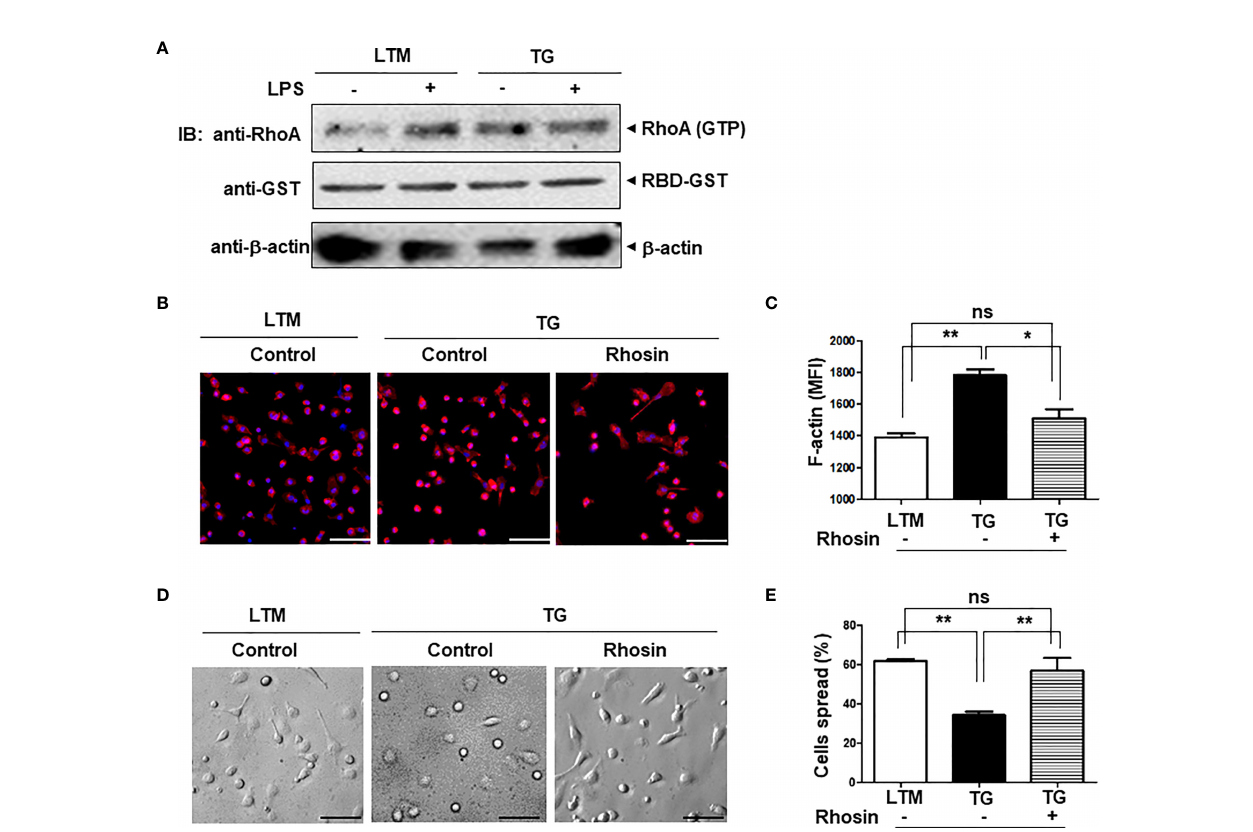
FIGURE 7 | Morphological changes in p190RhoGEF TG macrophages caused by the inhibition of RhoA. (A) PMs from LTM control and p190RhoGEF TG mice were either left unstimulated, or stimulated with LPS (1 m g/ml) at 37 ° C for 15 minutes. Cell lysates (400 m g) were incubated with rhotekin RBD-GST fusion protein beads (10 m g) at 4 ° C for 1 hour. Association of GTP-bound RhoA was determined with anti-RhoA Ab. Amounts of beads and lysates used in each sample were shown by IB with anti-GST and anti- b -actin Abs, respectively. Experiments were repeated twice with similar results. (B) LTM and TG PMs were attached to